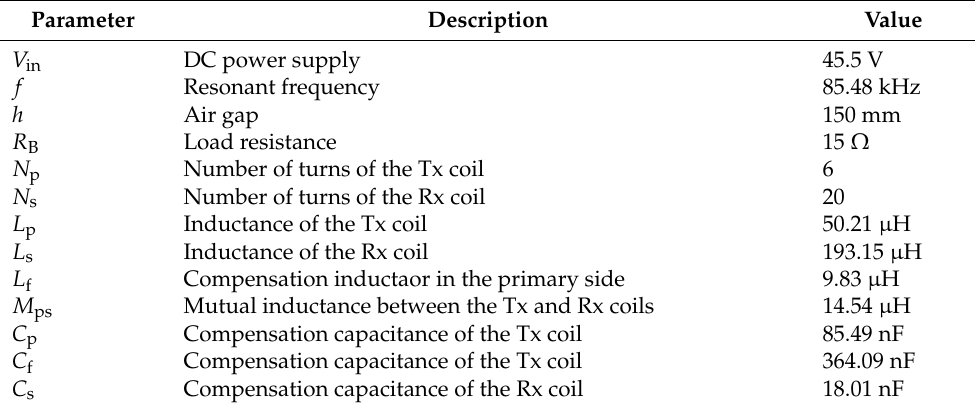
Table 4. Parameters of the LCC -S-compensated two-coil WPT system.